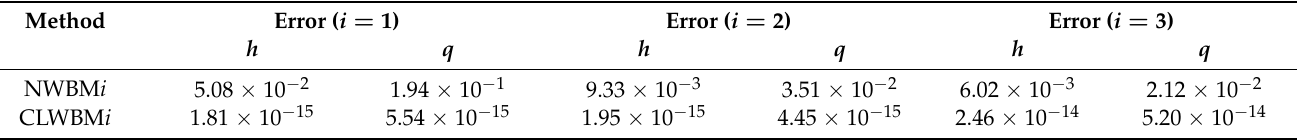
Table 13. Test 3.3. Differences in L 1 -norm for NWBM i and CLWBM i ( i = 1,2,3) with respect to the stationary solution for the 100-cell mesh at time t = 5